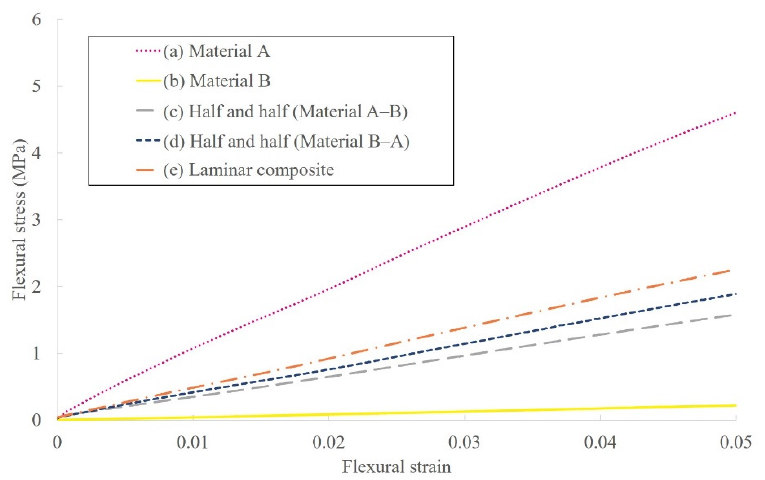
Figure 11. Flexural strain-stress graph.